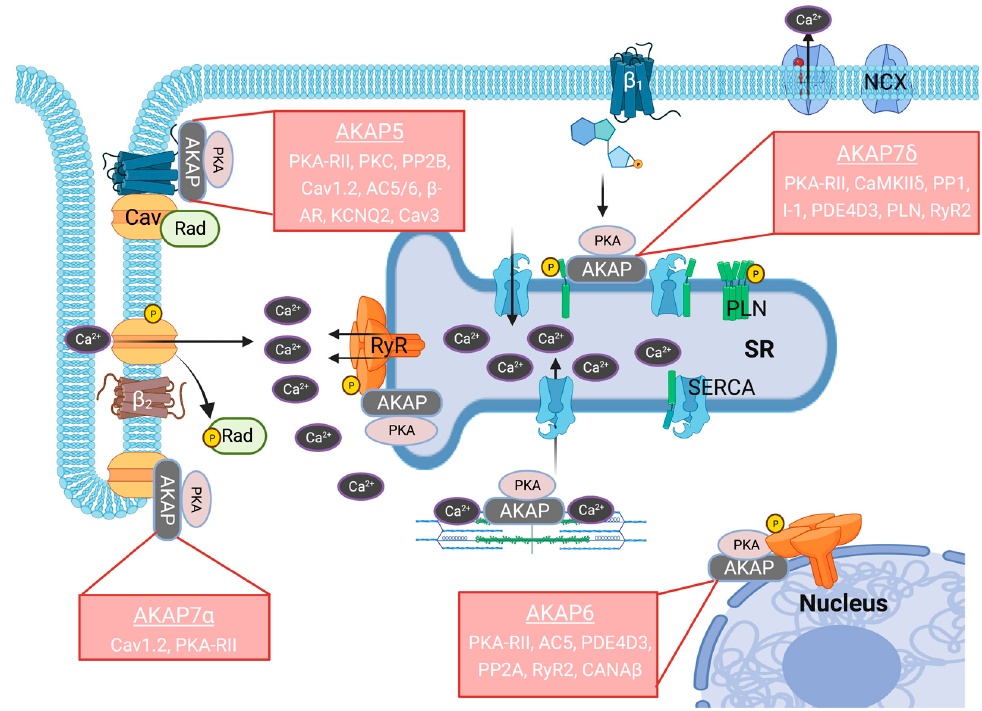
Figure 1. Calcium cycling in cardiac myocytes: depolarizing calcium currents via Cav1.2 induce CICR from SR via RyR2. This increase in cytosolic calcium increases the force of myofilament contraction. For relaxation, most of the calcium is taken back to the SR by SERCA2a, and a significant portion exits via NCX. The calcium-handling proteins Cav1.2, RyR2, and PLN are regulated by AKAP-bound PKA after β -adrenergic receptor ( β 1 and β 2 ) stimulation. Different AKAPs regulating the calcium-handling proteins are mentioned. Though AKAPs bind multiple proteins, only the binding partners that play a role in calcium cycling are listed. Illustrations in Figure 1 are created with BioRender.com.